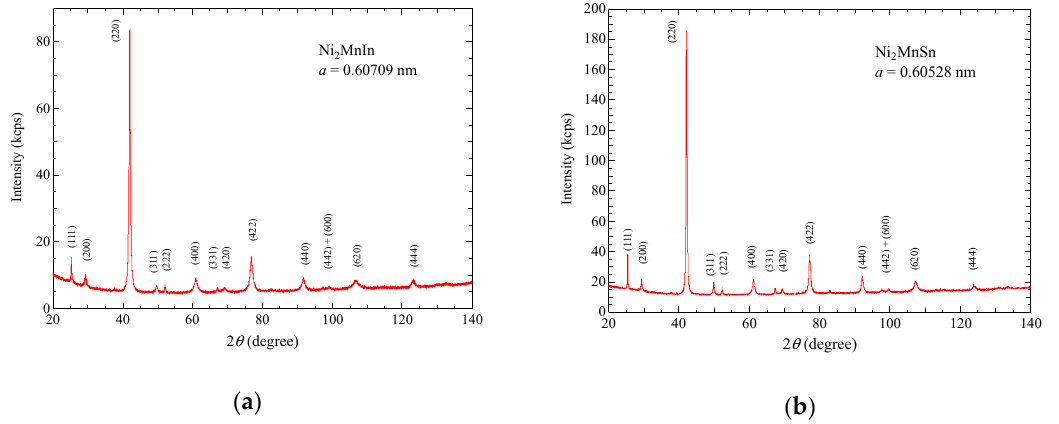
Figure 1. X-ray di ff raction patterns of ( a ) Ni 2 MnIn and ( b ) Ni 2 MnSn. Parenthesis indicates Figure 1. X-ray diffraction patterns of ( a ) Ni 2 MnIn and ( b ) Ni 2 MnSn. Parenthesis indicates the mirror the mirror indices. indices.